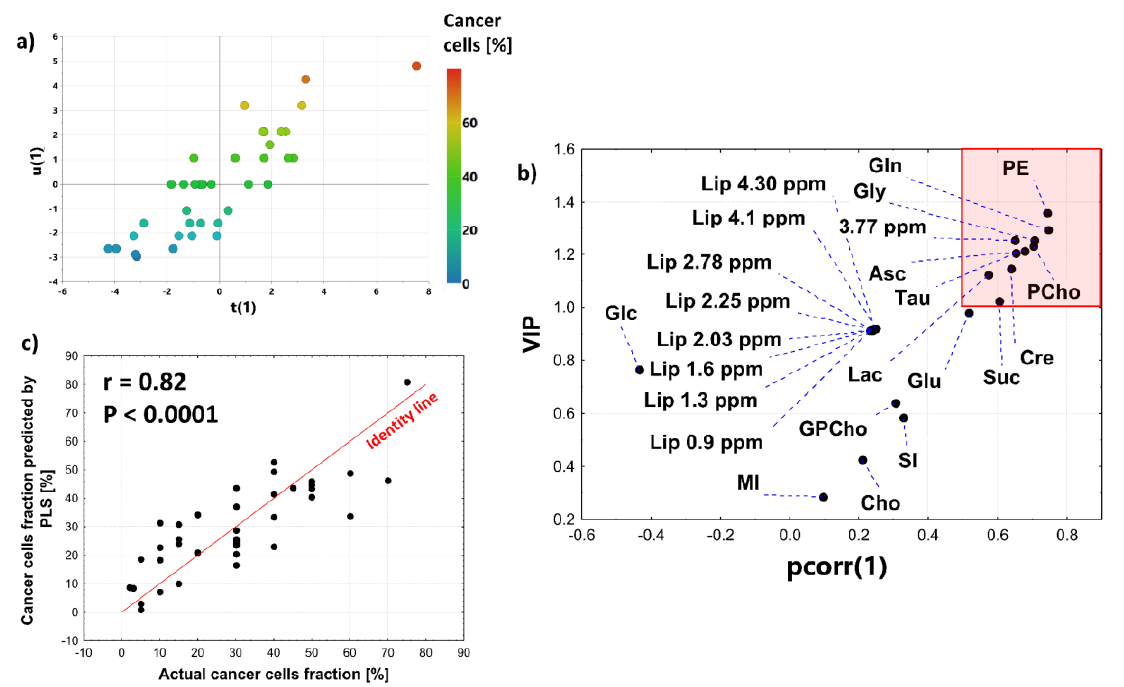
Figure 8. The OPLS model constructed to find the relationship between the metabolite levels (X) and a cancer purity (Y) in the samples containing mainly intratumoral fibrosis and cancer cells: ( a ) the u(1) vs. t(1) scores plot, ( b ) the pcorr(1) vs. VIP plot (the red shaded region corresponds to the VIP values > 1 and pcorr(1) > 0.5) ( c ) the cancer cells content predicted by the model (based on